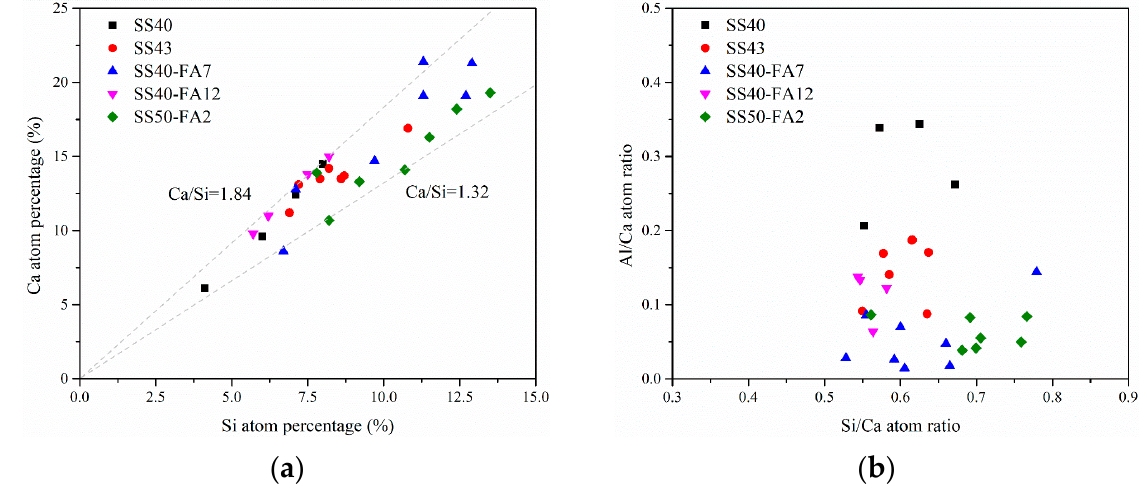
Figure 11. ( a ) Ca and Si atoms percentage, ( b ) Si/Ca and Al/Ca atomic ratios of C-(A)-S-H. The Al/Ca ratio of pastes ranges from 0.02 to 0.34, and the average Al/Ca is 0.12 (Figure 11b). Al enters C-S-H mainly through silicic acid chain bridging sites [46], forming dense C-A-S-H gels [47]. The Al substitutes Si in C-S-H and high Al/Ca provide excellent mechanical properties